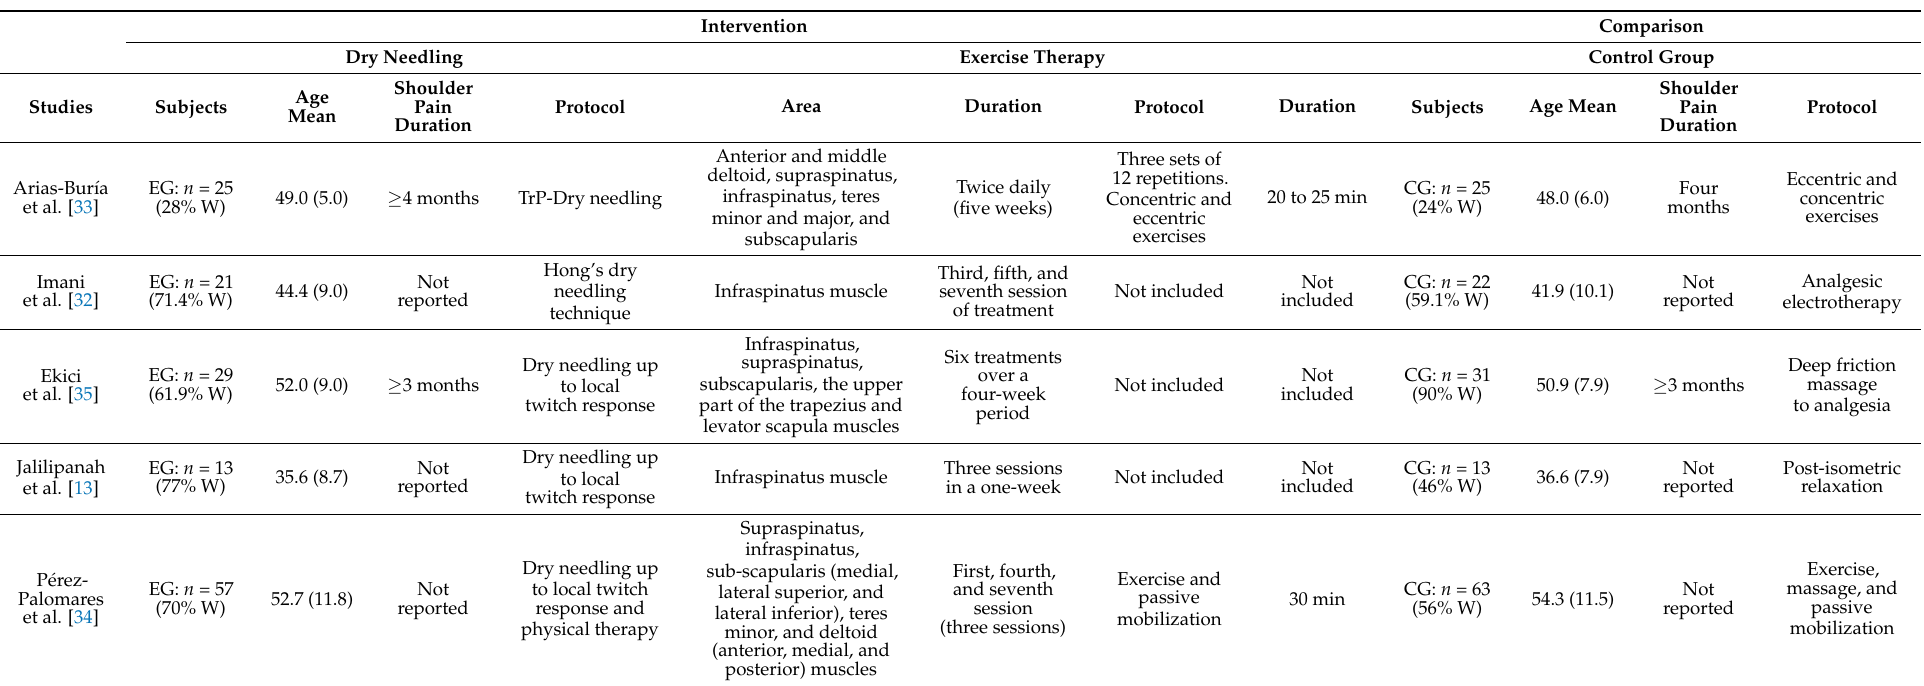
Table 1. Characteristics of the included